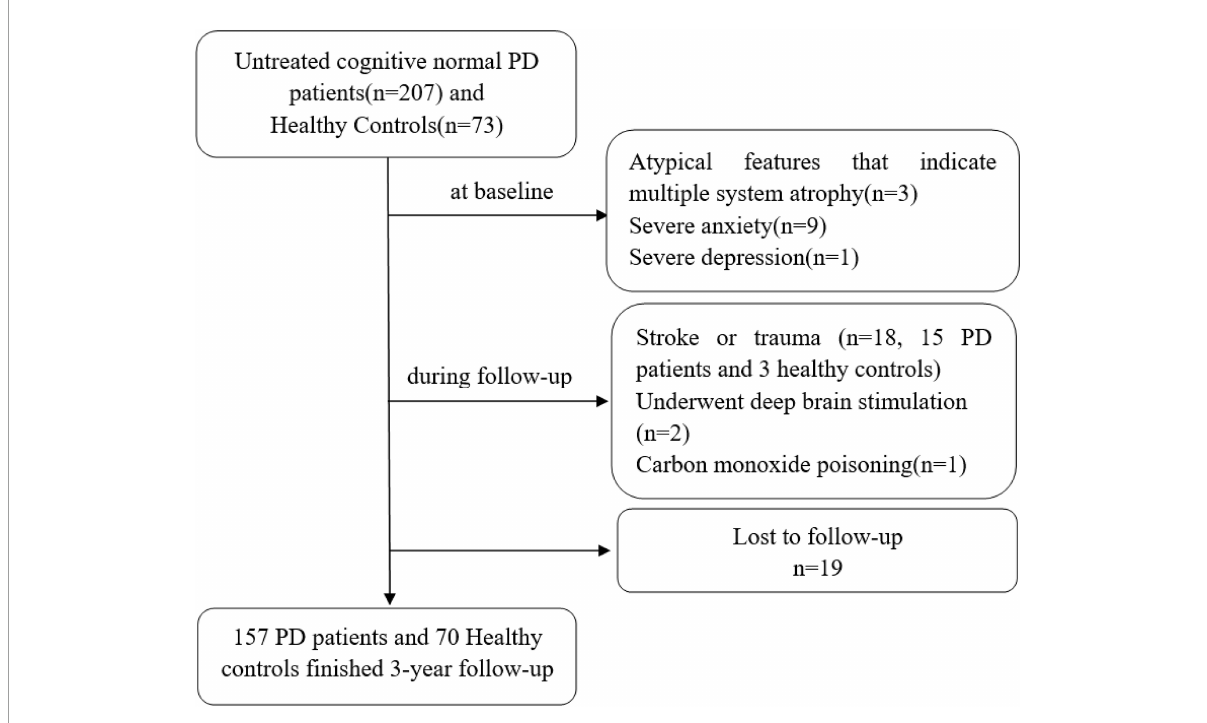
FIGURE1 Description of the study population. PD indicates Parkinson’s